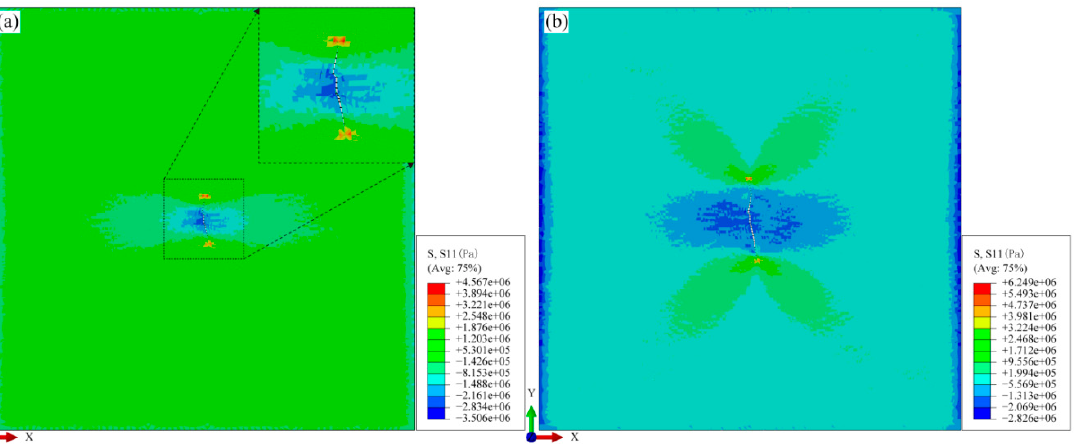
Figure 12. Horizontal stress contours at different fracturing stages under the mineral-heterogeneity model. ( a ) is the initial stage of fracturing. ( b ) is the middle stage of fracturing. Minerals indirectly affected the fracture-propagation path by changing the stress